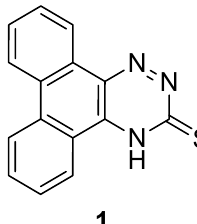
Figure 1. Structure of compound 1 .